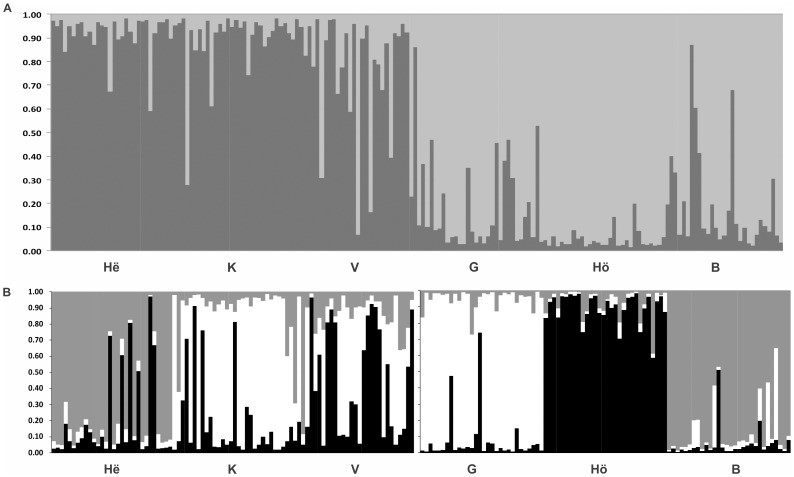
Hierarchical Bayesian clustering for the six populations genotyped at 117 neutral loci.First (upper barplot, Fig. 2A), inferred ancestry of individuals was calculated after averaging ten STRUCTURE [71]–[73] runs with CLUMPP [76]. The number of clusters that best fits the total data was K = 2 after Evanno's [74] correction (ΔK = 306). Then (lower barplots, Fig. 2B), the same procedure was performed again for every cluster obtaining K = 3 for each of the subsets (ΔK = 58 and ΔK = 242 for high and low temperature respectively). Sites are ordered in the barplots according to the N-S directions that corresponds to decreasing habitat temperatures.